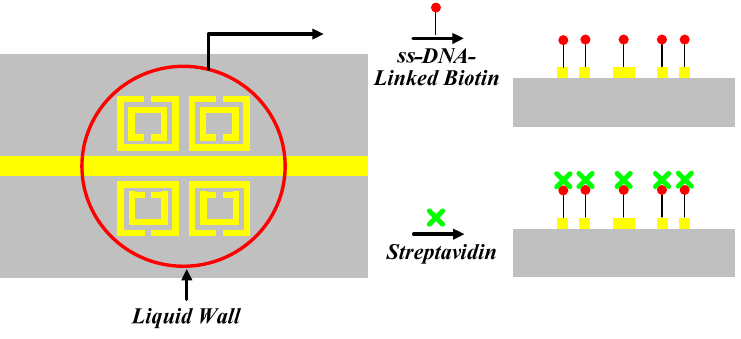
Figure 2. Binding bioprocess of biotin and streptavidin: the liquid wall (red circle) shows the receptacle for liquid solution confinement. The sample was immersed in biotin (red) for 12 h, rinsed, and exposed to streptavidin (green) for 6